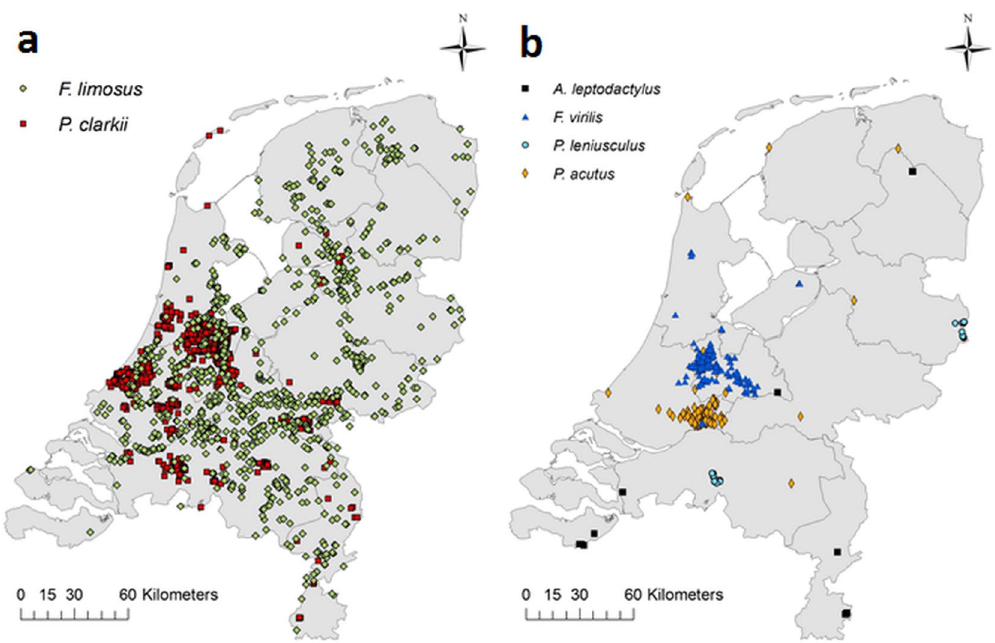
Figure 2. Distributions of ( a ) F. limosus and P. clarkii and ( b ) A. leptodactylus , F. virilis , P. leniusculus and P. acutus in the Netherlands. These maps were generated using ArcMap 10.2.2 (https ://deskt op.arcgi s.com/en/ arcma